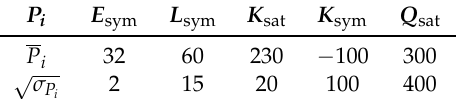
√ Table 1. The mean P i and standard deviation σ P of the multivariate Gaussian, where σ P i variance of the parameter P i . Our equation of states (EoSs) are sampled using the initial distribution for P i assuming that there are no correlations among the parameters. All the quantities are in units of MeV. P